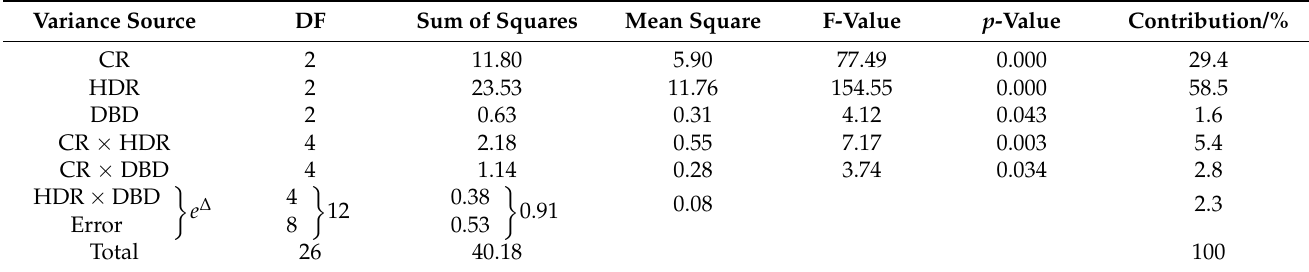
Table 4. Analysis of variance for drag force of test